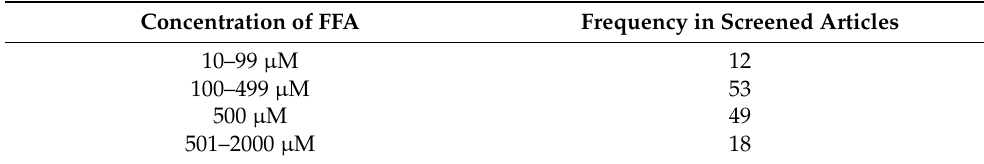
Table 1. Frequency of FFA concentrations used in screened literature focused on lipotoxicity ( n = 132). Free fatty acids